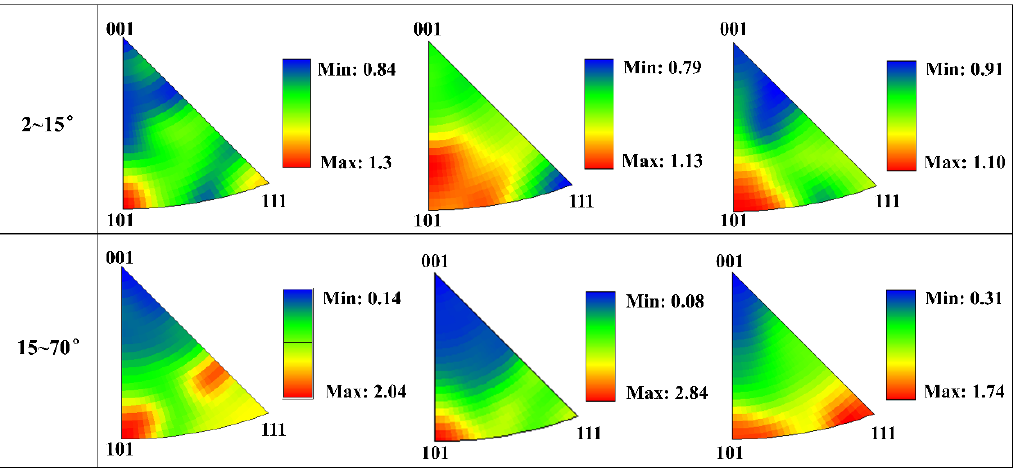
Figure 14. The rotation axes distribution for the deformed grains shown in Figure